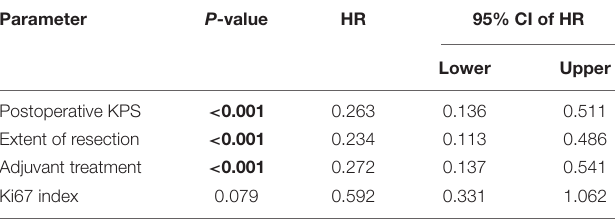
TABLE 3 | Cox proportional hazards model for OS in all